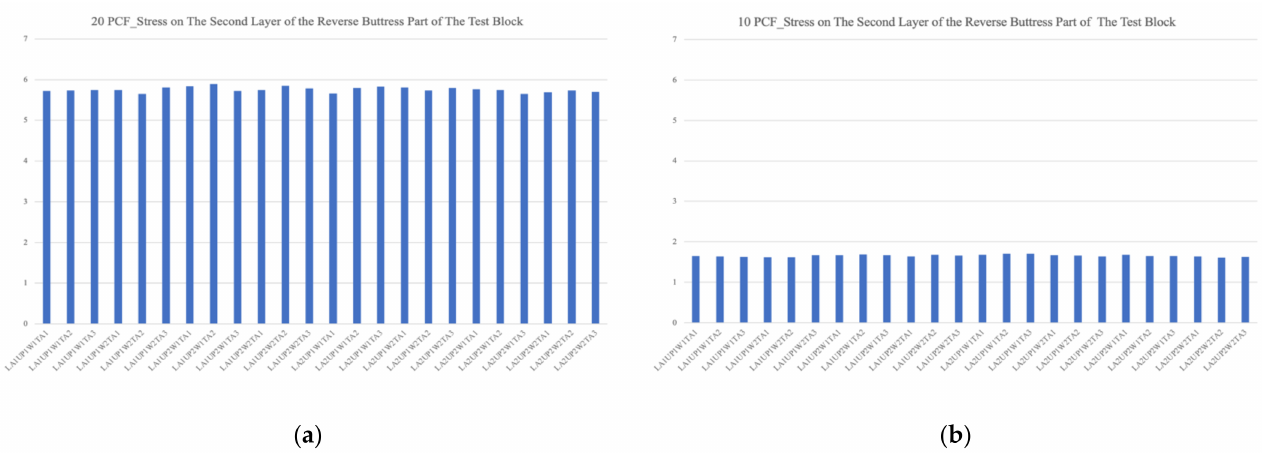
Figure 11. Comparison of the stress on the second layer of the reverse buttress part of test block of 24 groups in ( a ) 20 PCF and ( b ) 10 PCF.